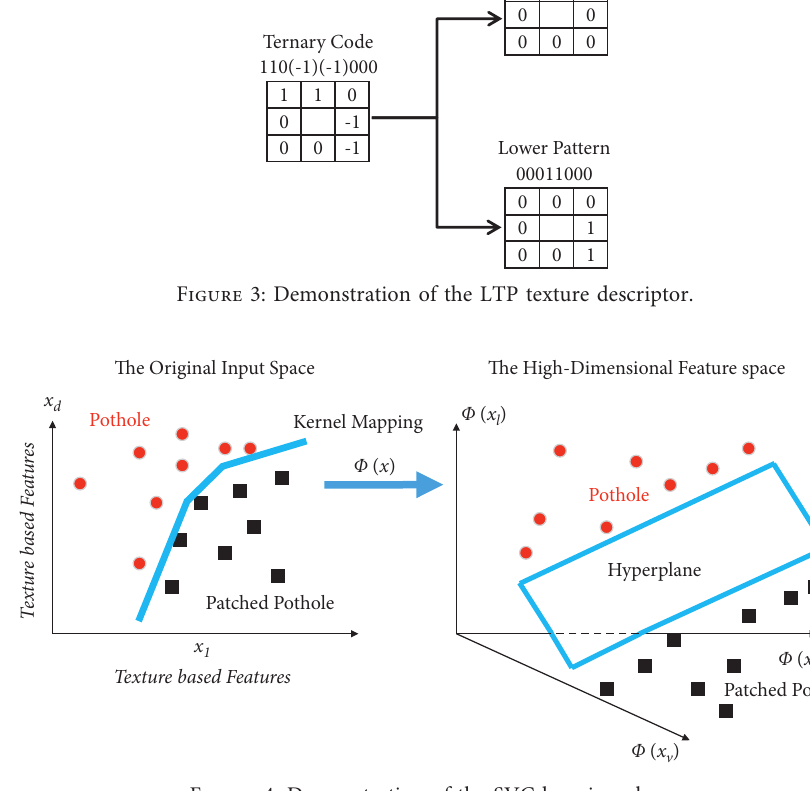
Figure 4: Demonstration of the SVC learning